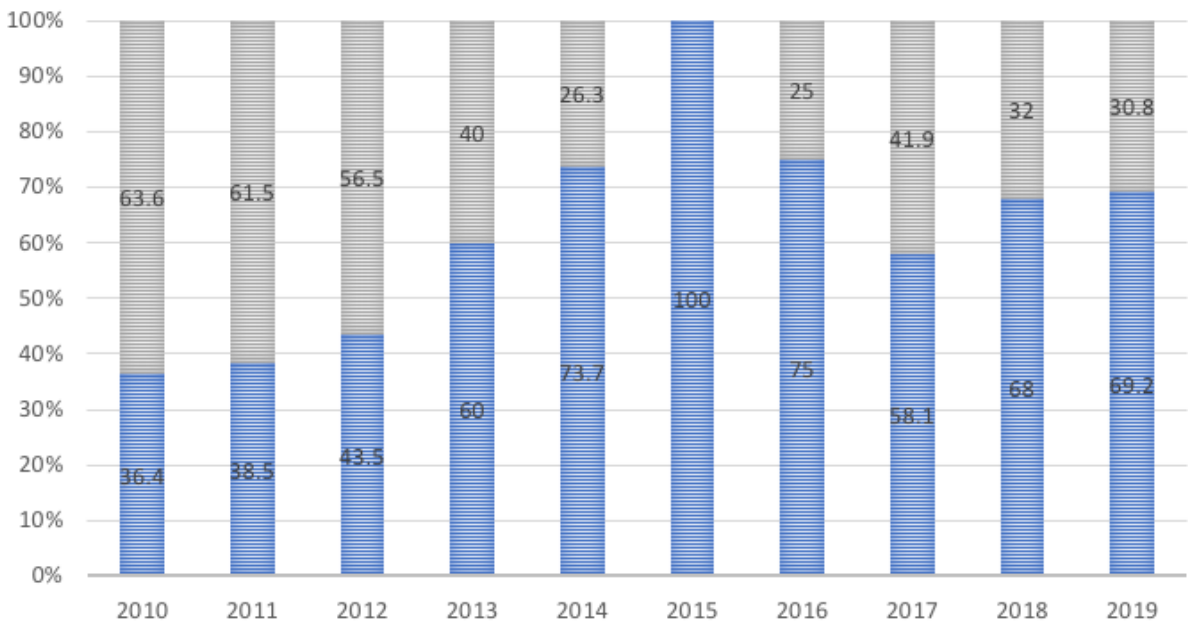
Figure 1. Proportion of the annual ICU/OR re-explorations over the years. ICU: Intensive Care Unit, OR: Operating Room.